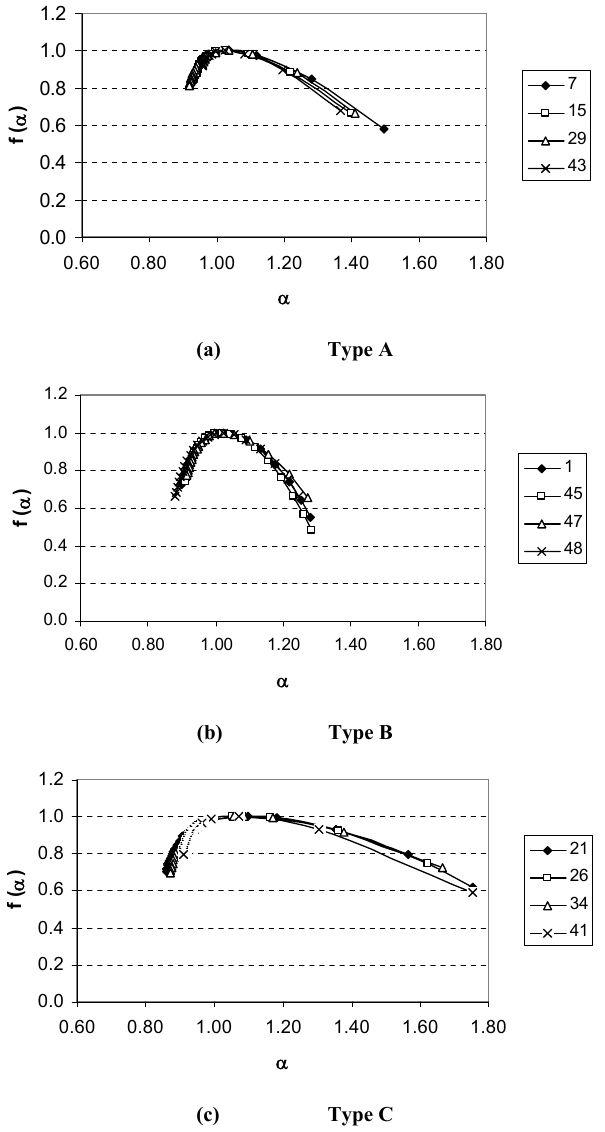
Fig. 5. Selected examples of singularity spectra (types as in Fig. 4).